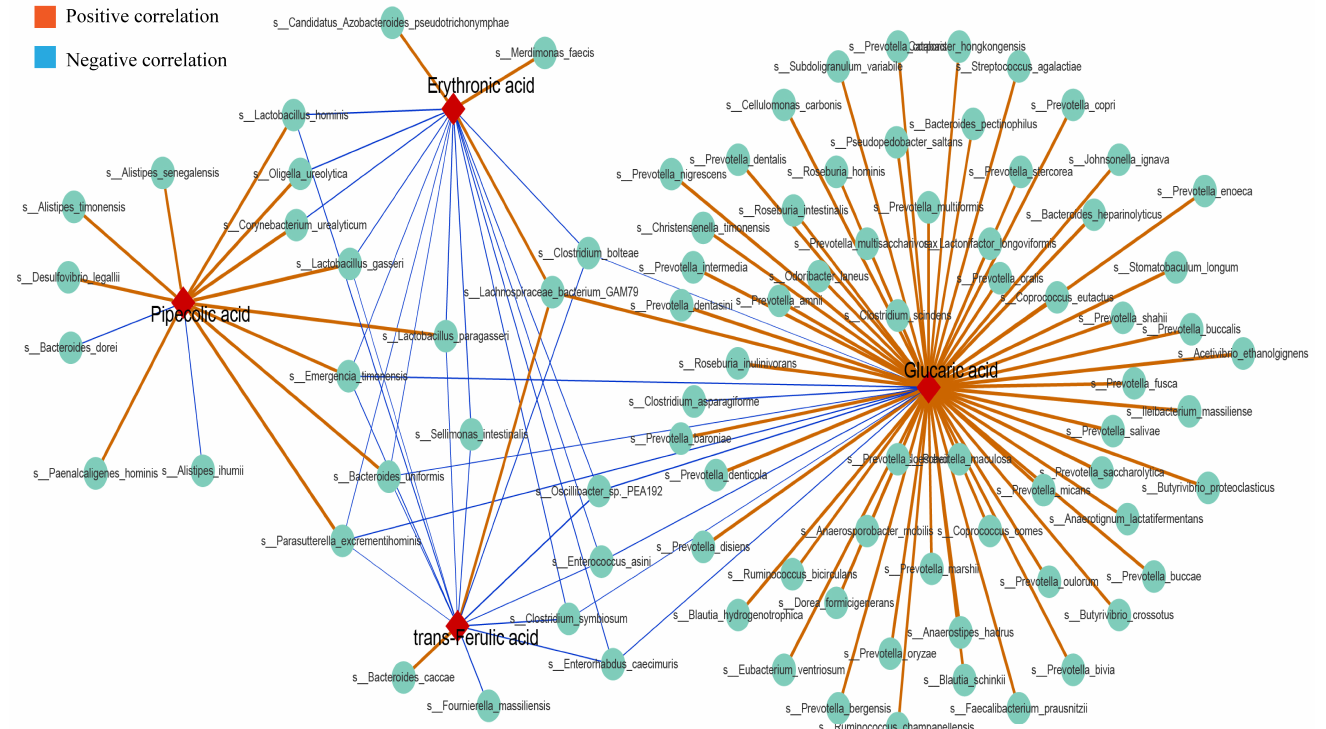
Figure 9. Species that are significantly associated with erythroid acid, glucaric acid, pipecolic acid, and trans-ferulic acid. The orange and blue lines represent positive and negative correlations, respectively ( p < 0.05).